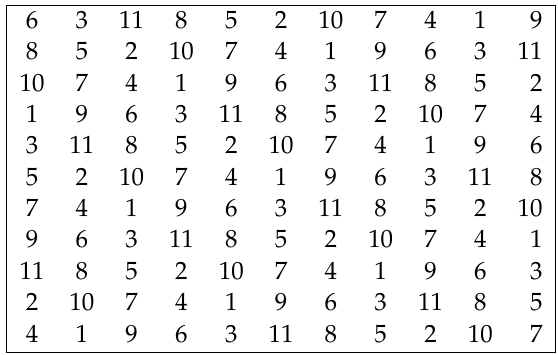
A pandiagonal plane parallel to ACGE